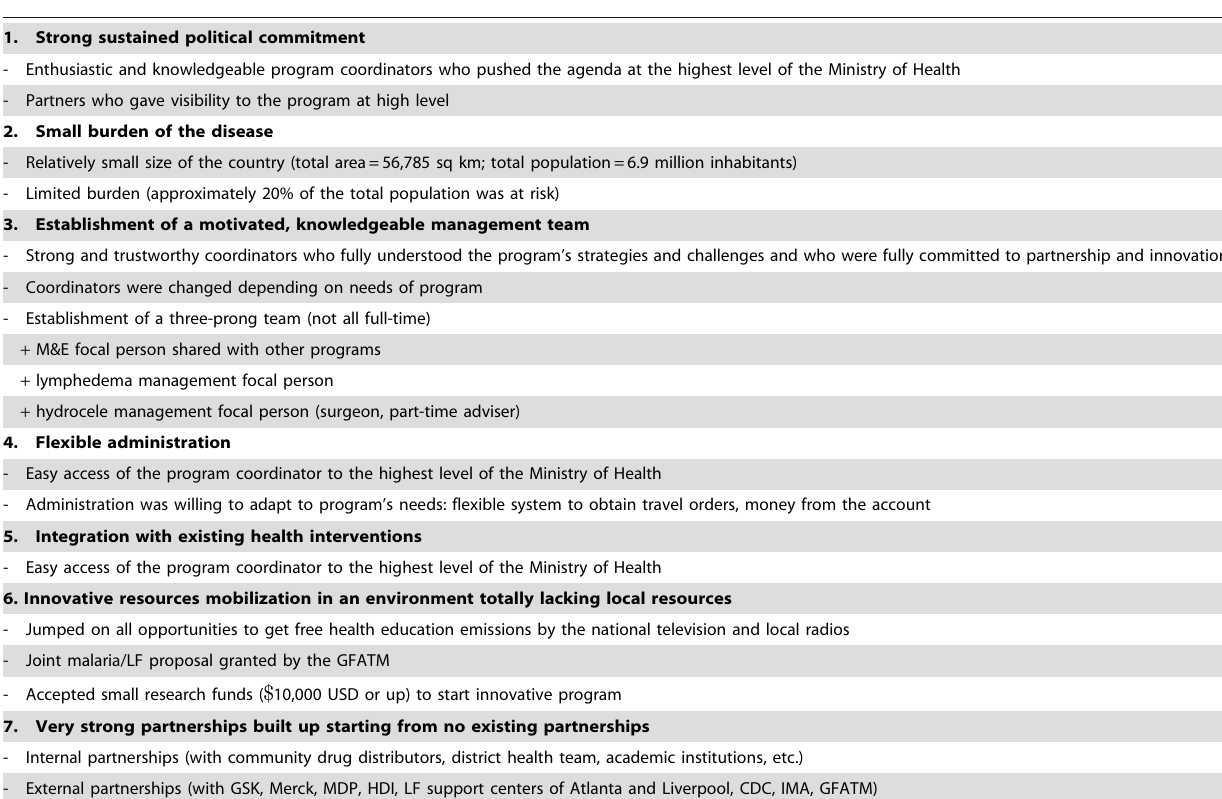
Table 2. Determinants of success of the National Program to Eliminate Lymphatic Filariasis in